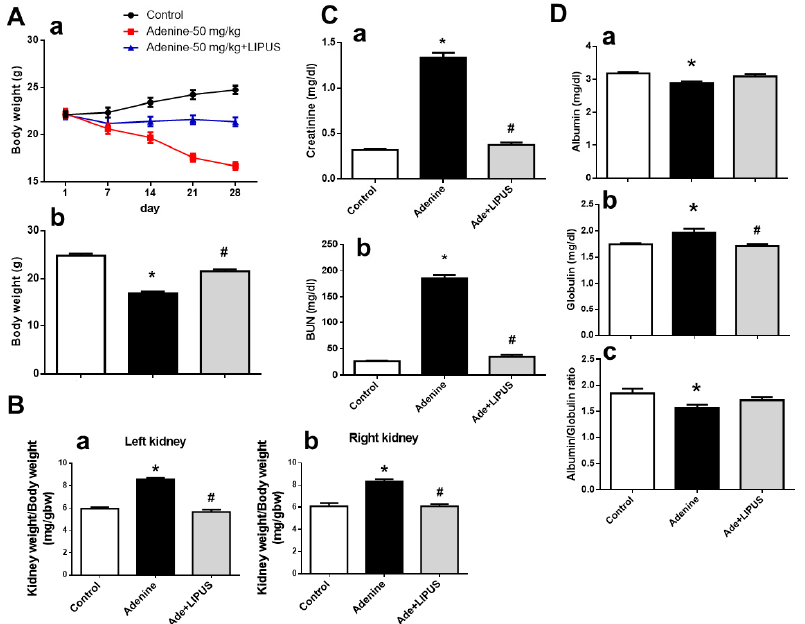
Figure 5. The effects of LIPUS on changes in body weight, relative kidney weight, and serum biochemistry in CKD mouse models following adenine administration (the mice were euthanized 28 days after adenine administration): ( A ) changes in body weight over time ( a ) and final body weight ( b ); ( B ) the relative weights of the left kidneys ( a ) and right kidneys ( b ); ( C ) serum blood urea nitrogen levels (BUN, ( a )) and creatinine levels ( b ); ( D ) serum albumin levels ( a ), globulin levels ( b ), and albumin/globulin ratio ( c ). Data are presented as mean ± SD (n = 9): * p < 0.05 versus the control group; # p < 0.05 versus the CKD-alone group.